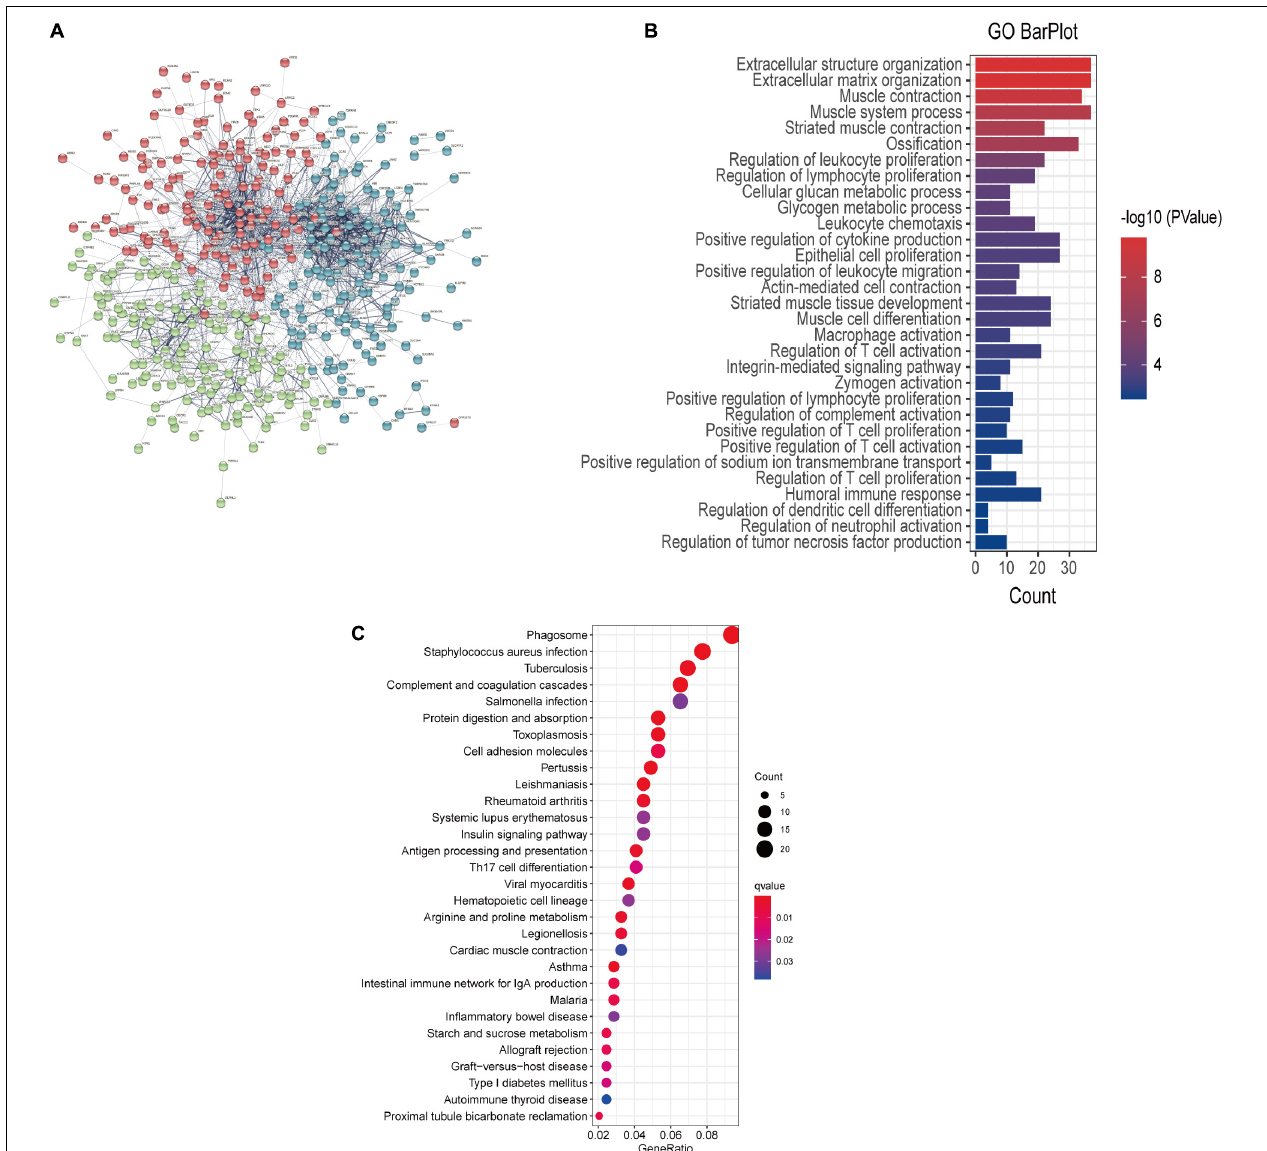
FIGURE 3 | (A) PPI network showing the interactions of the DEGs. The thickness of the line in the figure designates the strength of the correlation. (B) GO enrichment analysis and (C) KEGG analysis of the